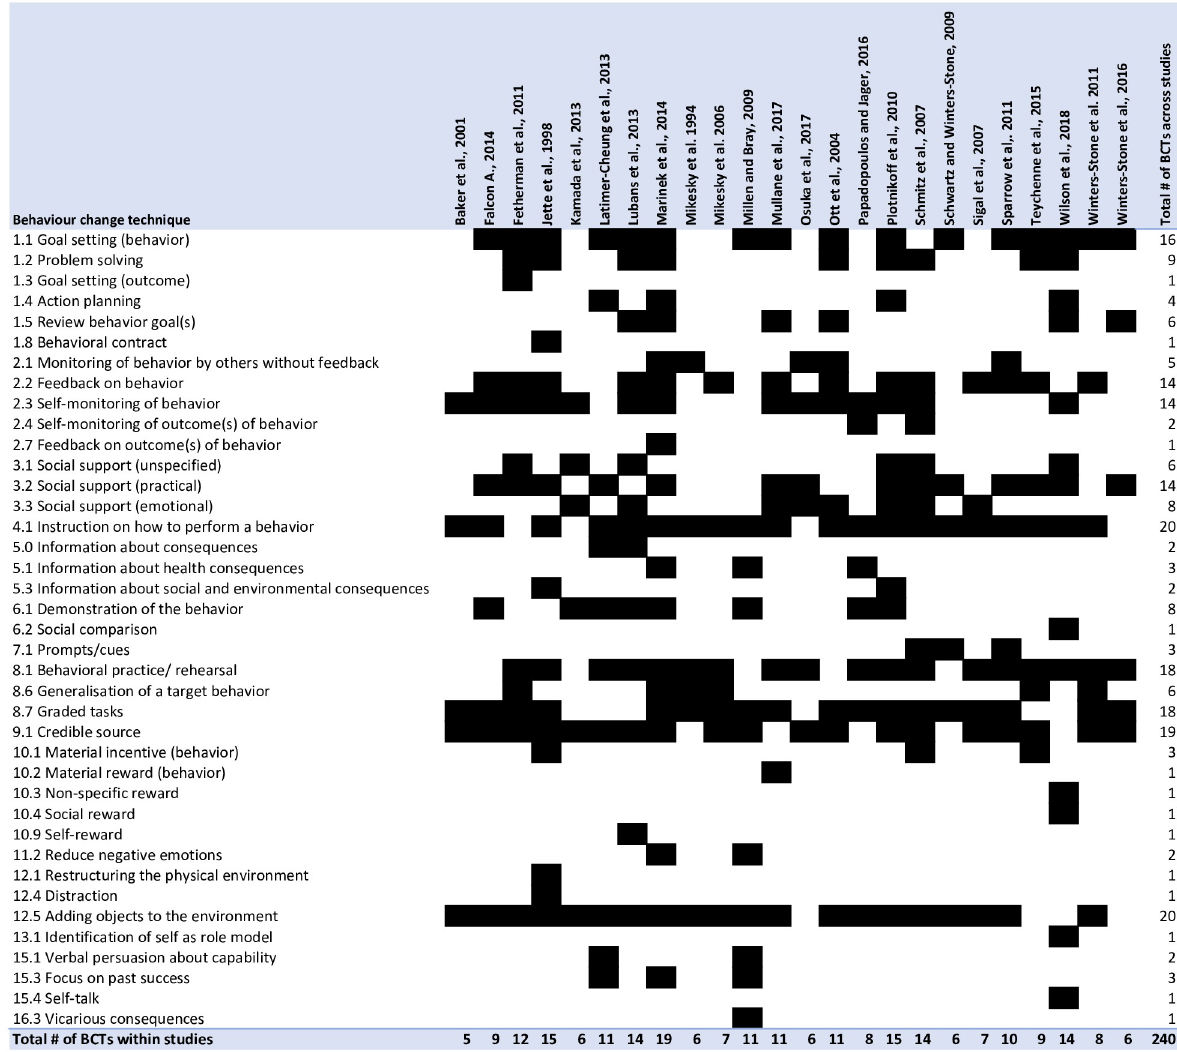
Fig 2. Summary of BCTs. Note: A shaded cell indicates a given BCT was